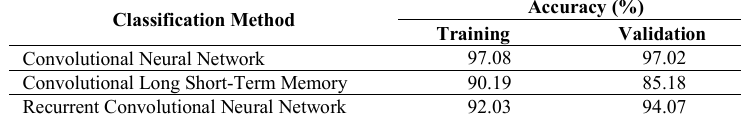
TABLE 6 C OMPARISON OF